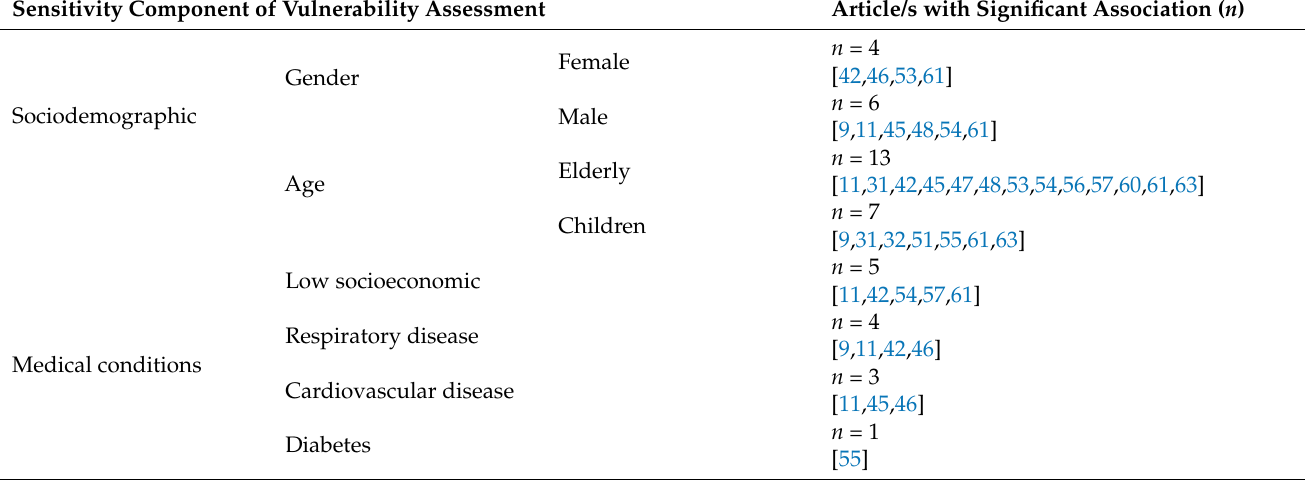
Table 3. Summary of sensitivity component of vulnerability assessment for heat-related